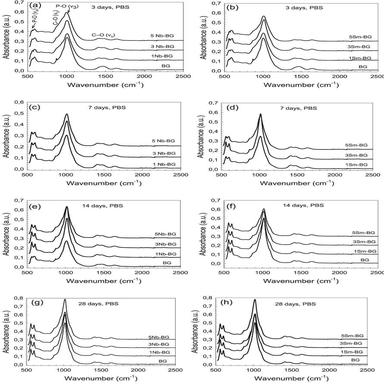
FTIR spectra of the Nb5+(left column) Sm3+ (right column)-containing bioactive glass powders treated in PBS for (a),(b) 3 days; (c),(d) 7 days; (e),(f) 14 days; (g),(h) 28 days.